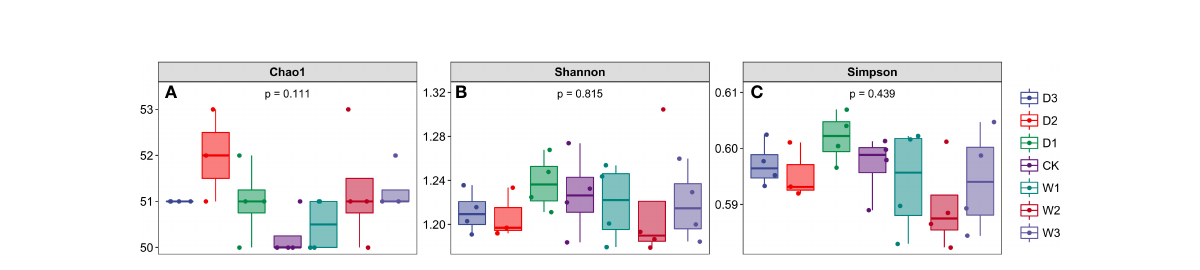
FIGURE 3 Alpha diversity index of soil bacterial community under seven precipitation gradients in the alpine steppe of Northern Tibet. (A) Chao1 index; (B) Shannon index; (C) Simpson